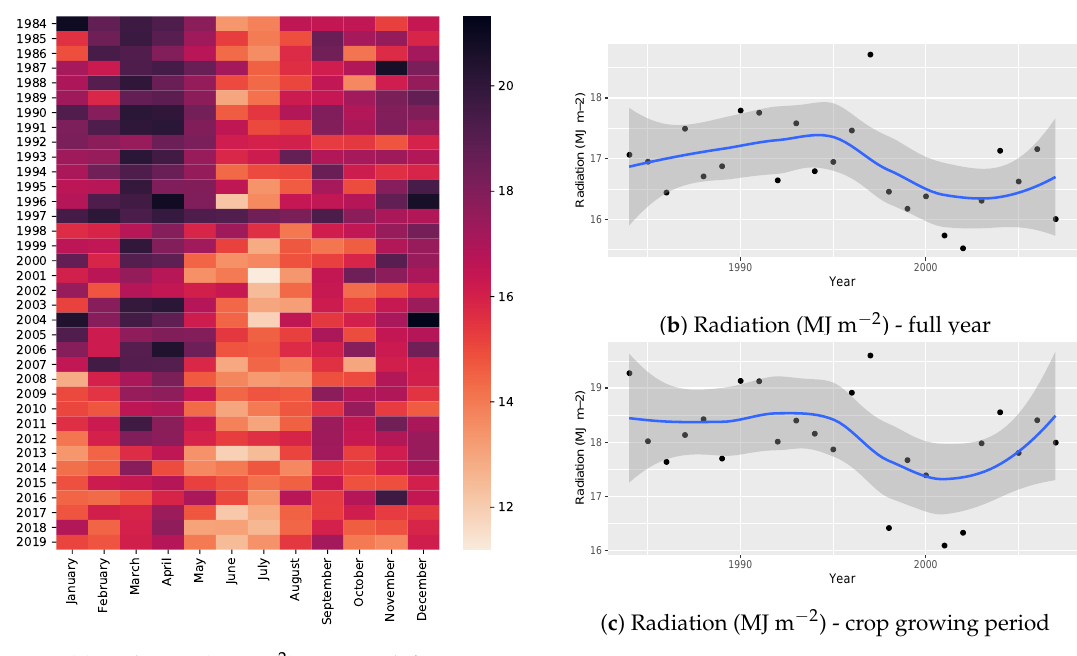
Figure A4. Time series of average radiation (MJ m − 2 ) in Guayas. ( a ) Heat-map of radiation (MJ m − 2 ) per each month and year from 1984 to 2019. The color scale represents the radiation (MJ m − 2 ). ( b ) Radiation averaged during the full year from 1984 to 2007. ( c ) Radiation averaged during the maize crop growing period in Ecuador (January–May) from 1984 to 2007. Each dot represents one record, the blue line shows the smoothed time series and the shaded area represents the 95% confidence interval.